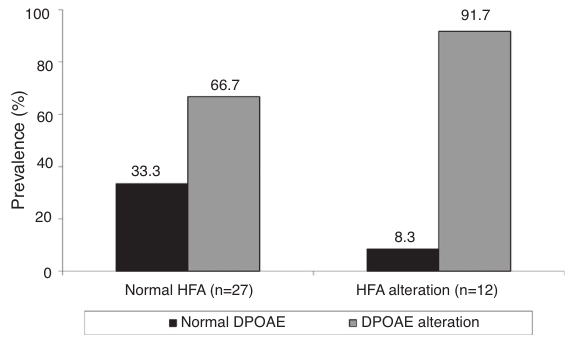
Figure 3 Association between HFA and DPOAE alterations in the study group. HFA, high frequency audiometry; DPOAE, distortion-product otoacoustic emissions.